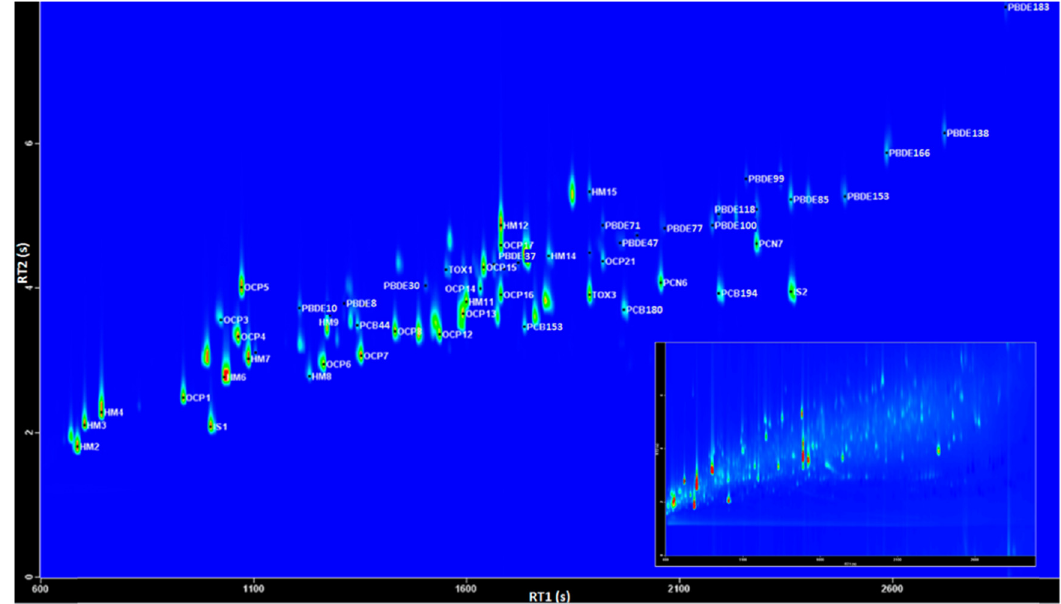
Figure 3: GC × GC - μ ECD chromatograms of the standard mixtures of well - separated target analytes and the internal standards. GC × GC - μ ECD chromatograms of the extract of an e ffl uent liquid - phase sample are shown in the inset at the lower right of the above fi gure [ 56 ]